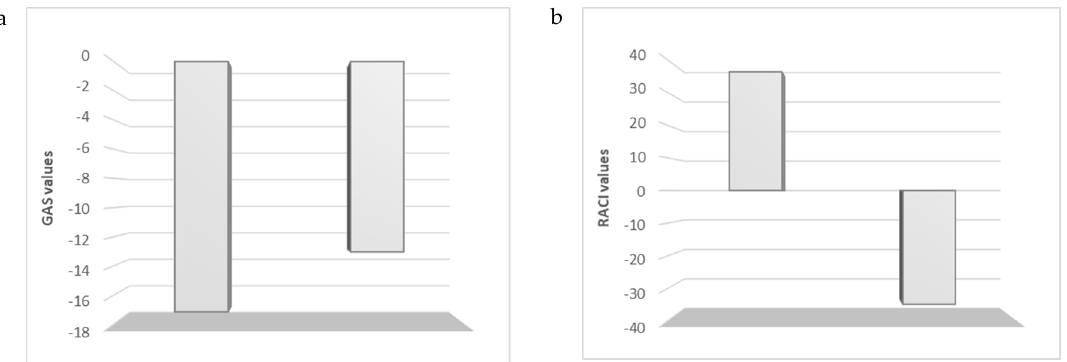
Figure 1. Global antioxidant score (GAS) ( a ) and Relative antioxidant capacity index (RACI); ( b ) values of rosemary essential oils.